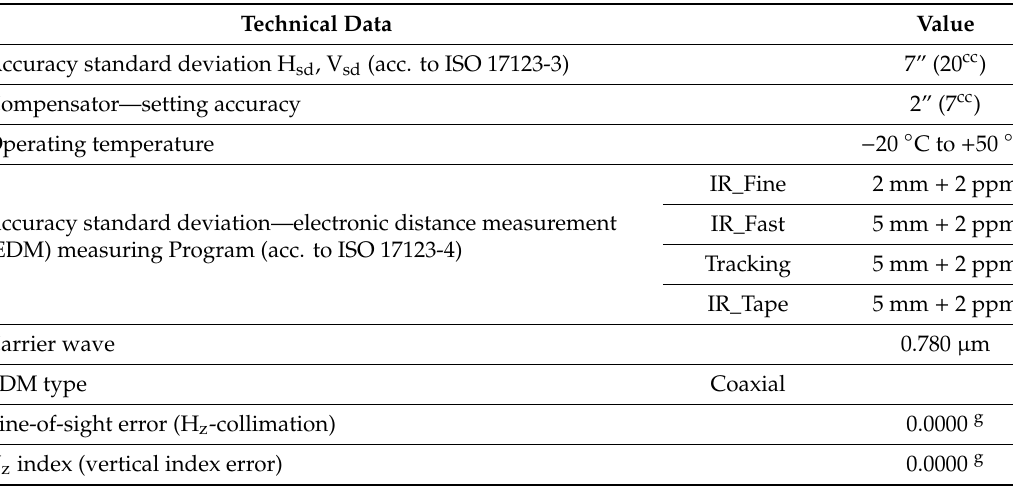
Table 1. Main technical characteristics of the Leica Geosystems TC407 total station.